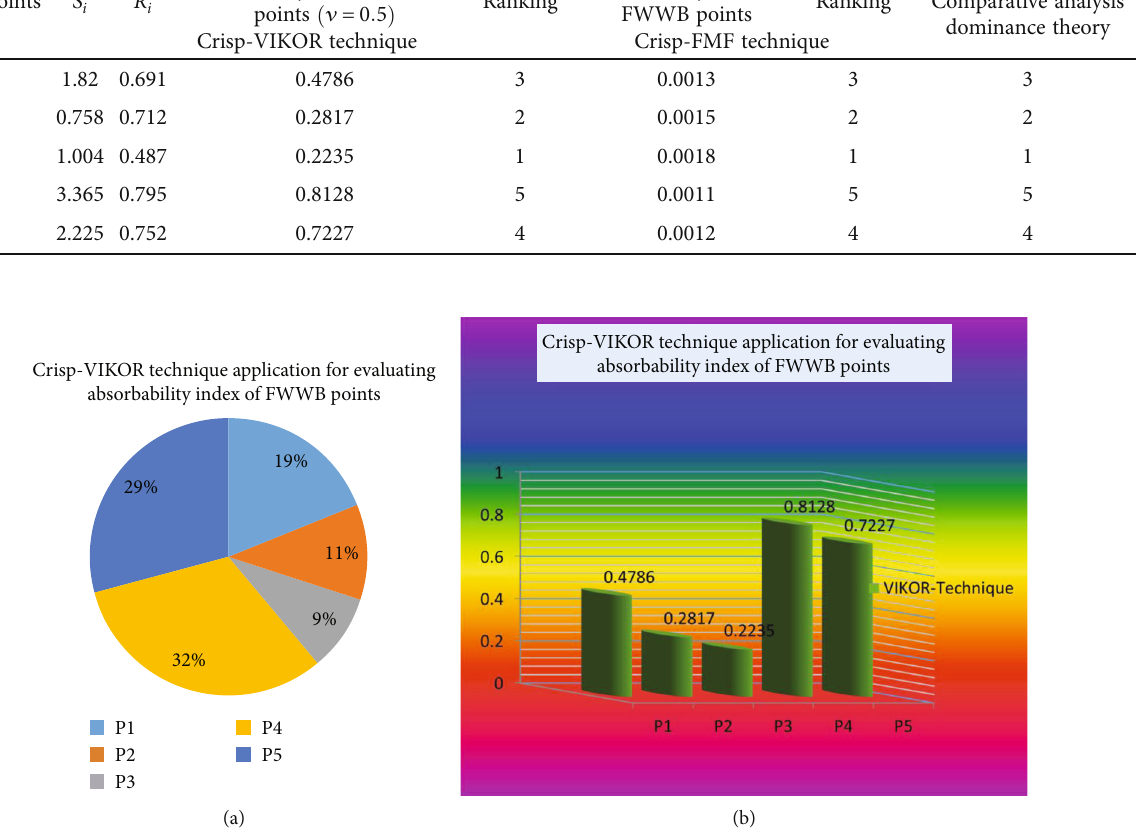
Figure 1: Crisp-VIKOR application for evaluating absorbability index of respective FWWB points vs. FsCS, shown by (a) pie and (b) bar